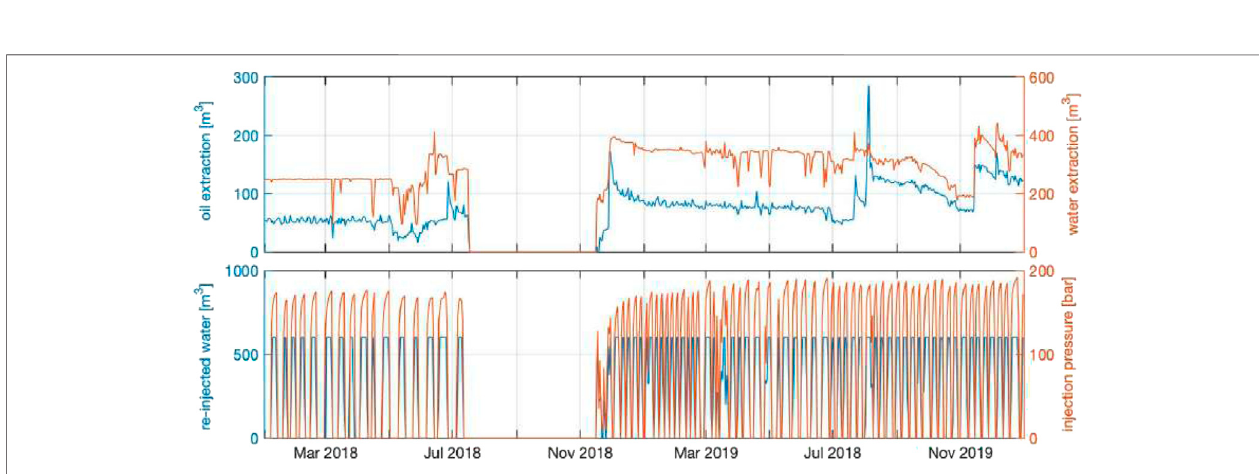
FIGURE 11 | (A) Time series of oil and water produced form the Cavone fi eld ( m 3 /day). (B) volume (in m 3 /day) and pressure (bar) of produced water re-injected through the Cavone14 well.